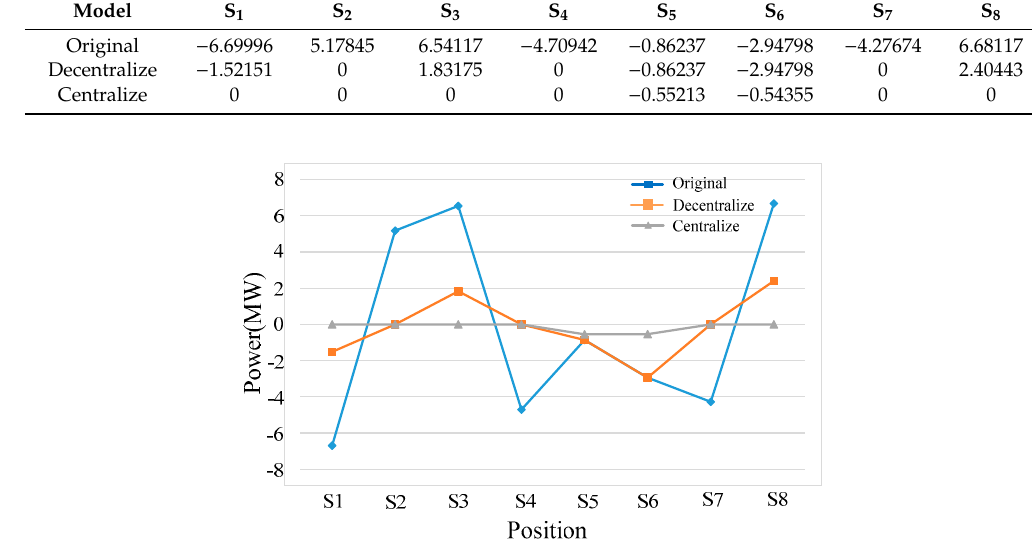
Figure 25. Results before and after control in case